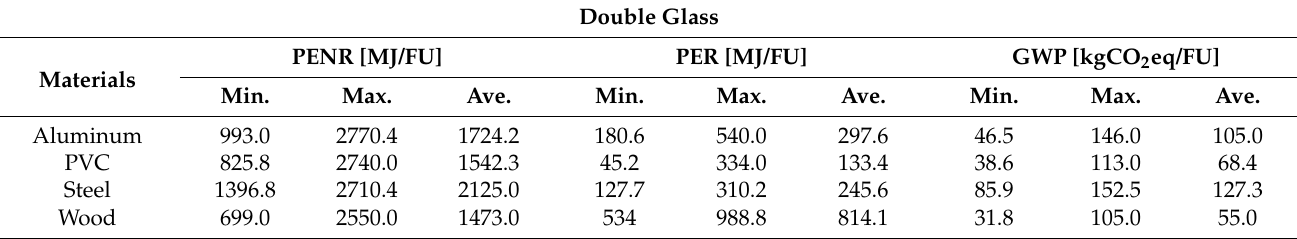
Table 6. Minimum, maximum and average values for PENR, PER and GWP of the double-glazed windows analyzed according to the different frame materials.